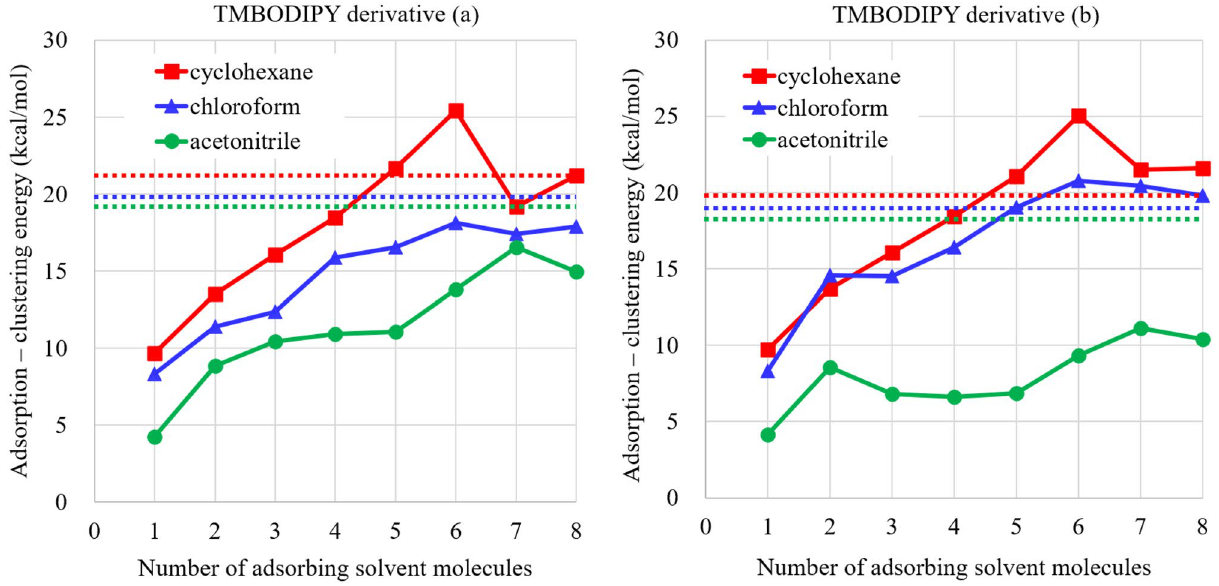
Figure 3. Adsorption energies of monolayer cyclohexane, chloroform and acetonitrile solvent molecules on the single sides of TMBODIPY derivatives ( a ) and ( b ) monomers, from which the clustering energies of the solvent molecules are subtracted, in terms of the number of the adsorbing solvent molecules. Calculations are performed by ω B97XD/cc-pVTZ method with the CPCM solvent effect corresponding to the adsorbing solvent molecules. The π -stacking energies of TMBODIPY derivatives ( a ) and ( b ) dimers in cyclohexane, chloroform and acetonitrile are illustrated as red, blue and green dotted lines, respectively.